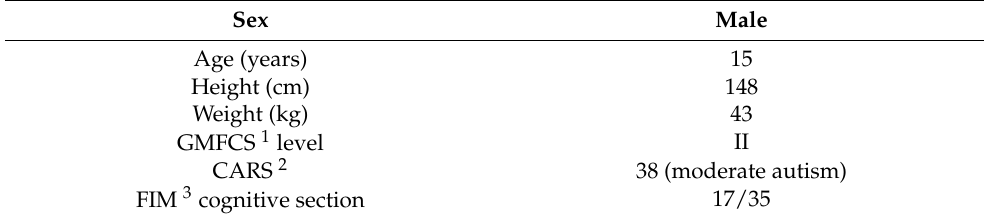
Table 1. Clinical characteristics of the